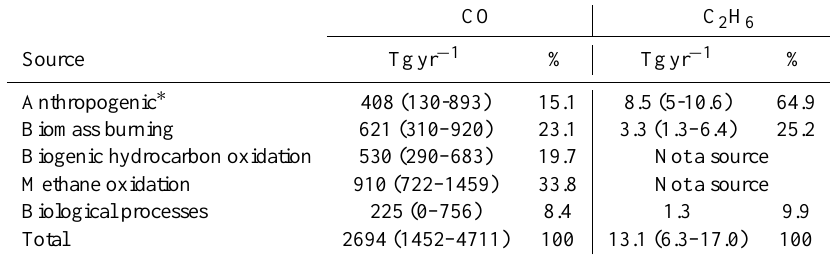
Table 1. Global sources of CO and C 2 H 6 (Tgyr − 1 and % of total). CO data are from Holloway et al. (2000) and C 2 H 6 data are from Xiao et al. (2008).